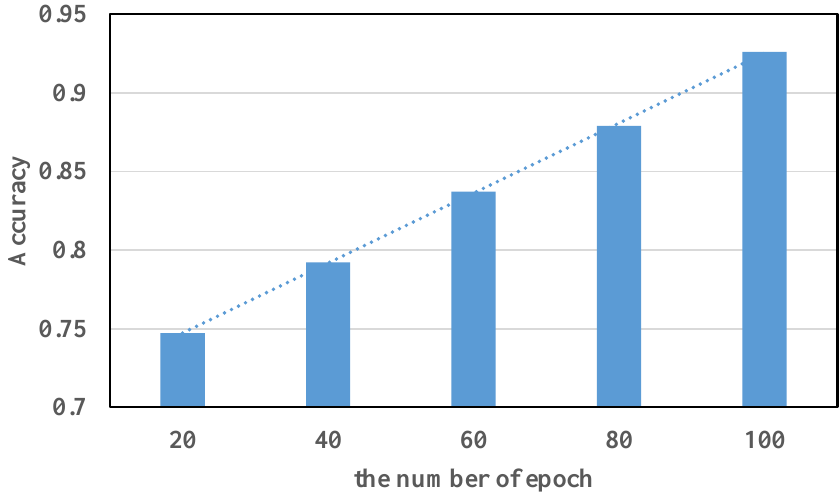
Figure 14. Different numbers of epochs.